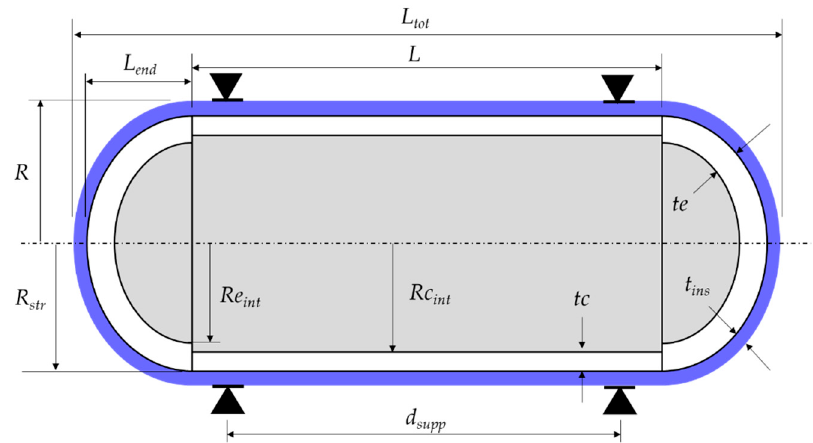
Figure 7. Longitudinal section of a generic hydrogen tank composed of a cylindrical central part and two semi-ellipsoidal endcaps, both covered by an external layer of insulation material (in blue). The other relevant parameters indicated in Figure 7